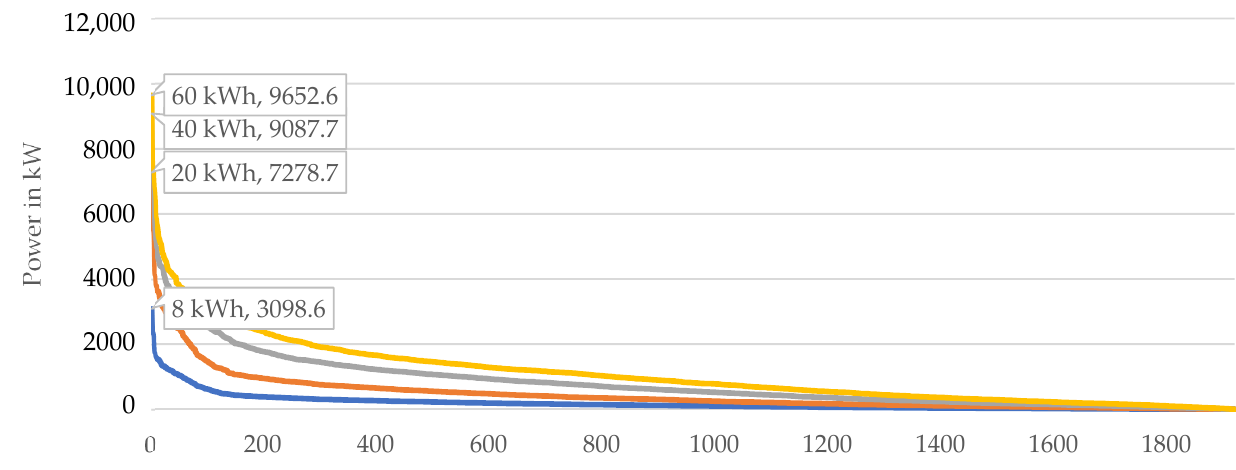
Figure 12. Sorted summed connector power when employing the price optimization strategy. For example, if during each charging process 40 kWh should be charged, during ~1400 h of the observed 1921 h, the chargers consumed 1000 kW or less.